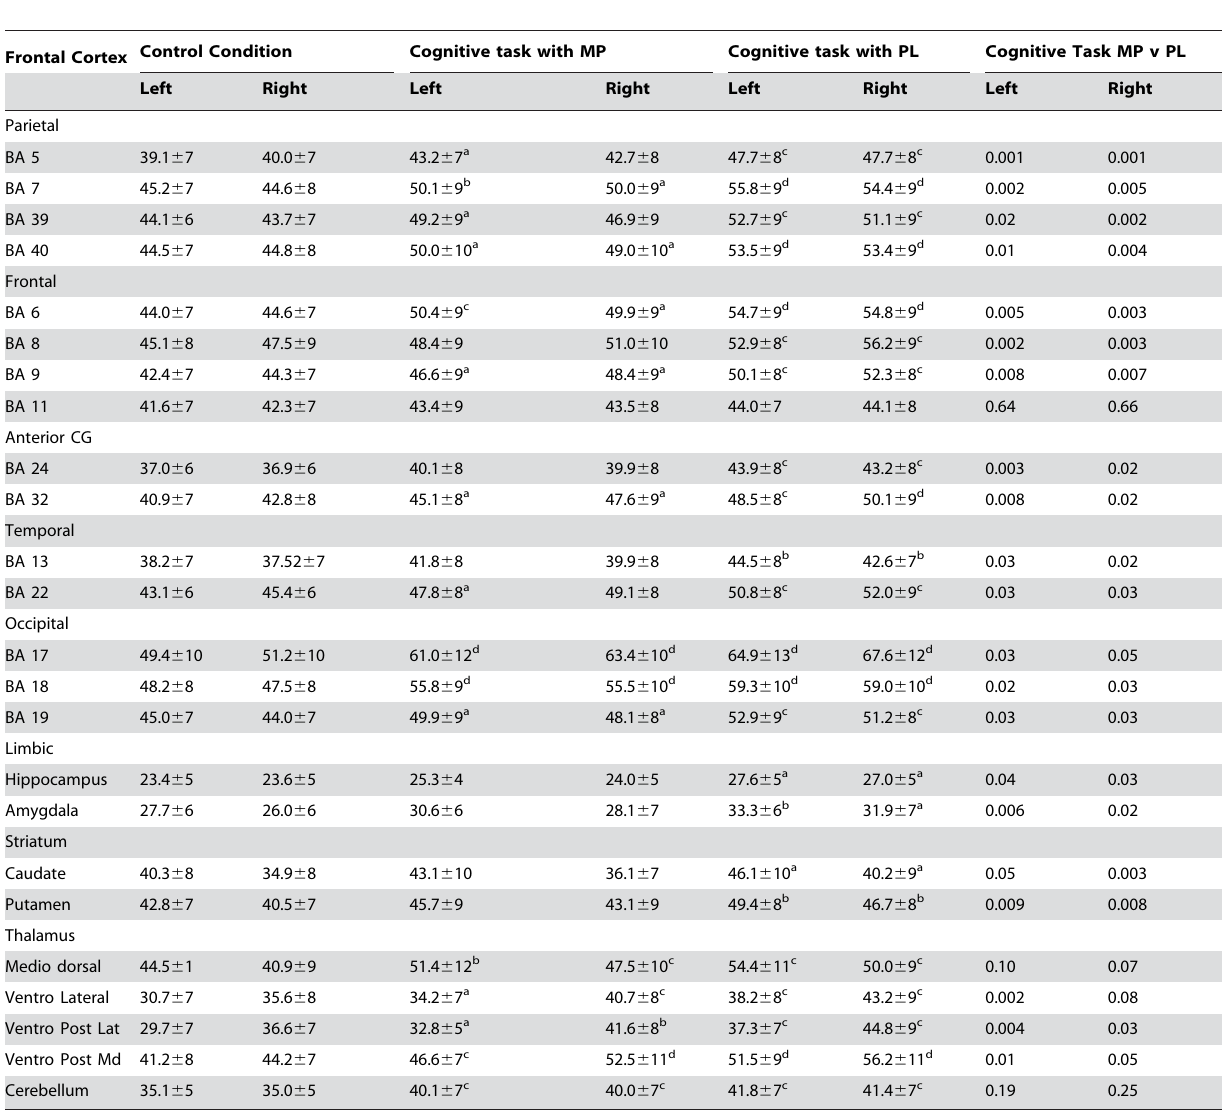
Table 2. Regional glucose metabolism ( m g/100 g/min) when subjects were tested during the neutral non-task with placebo (control condition), cognitive task with MP and cognitive task with placebo.